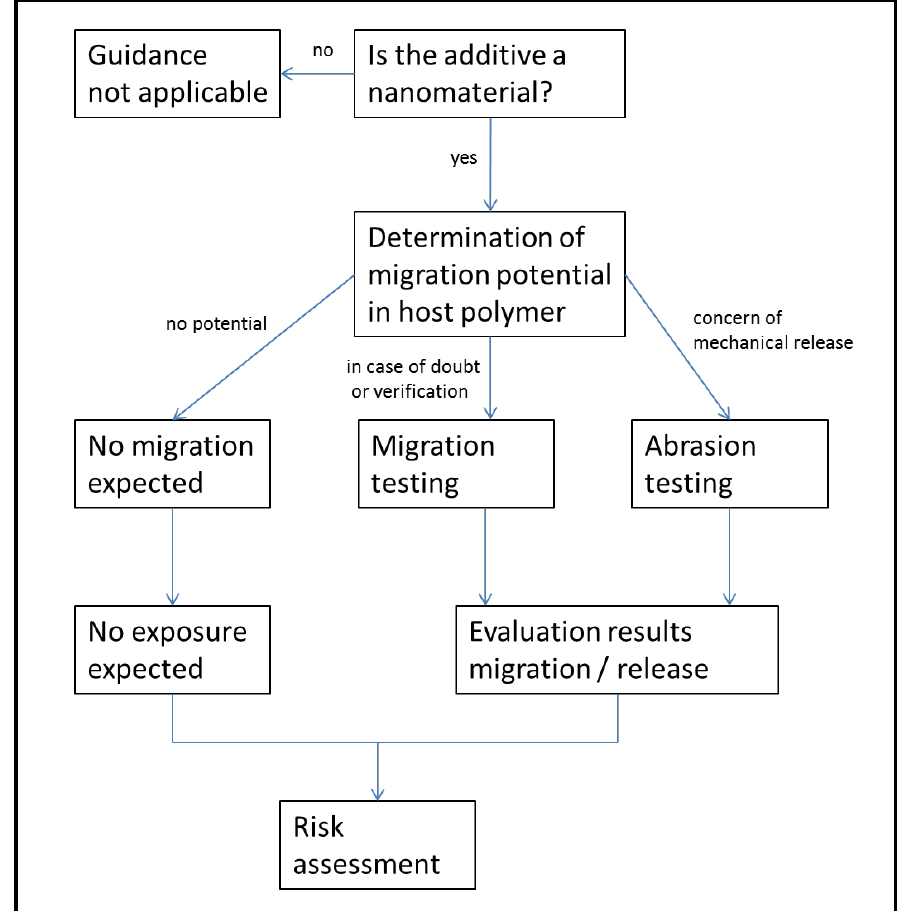
Figure 1. Overview of the test approach workflow.